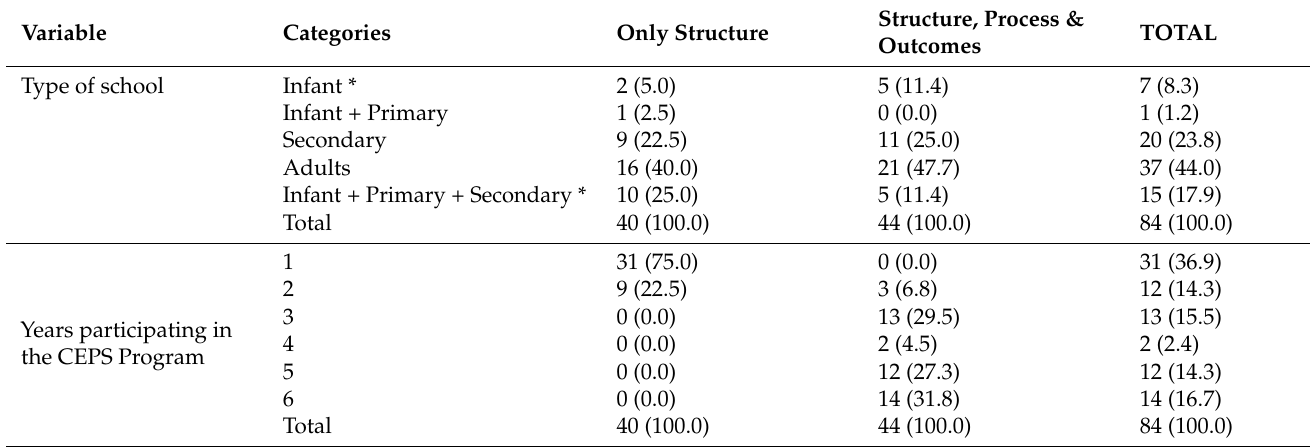
Table 1. The schools (cid:48) characteristics according to the evaluation of the CEPS